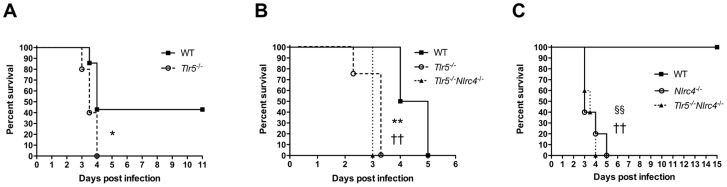

Tlr5 and Nlrc4 independently contribute to survival in respiratory melioidosis.Wild type (WT), Tlr5
−/−, Tlr5
−/−
Nlrc4
−/−, or Nlrc4
−/− mice were infected with A) 361 CFU/lung B) 400 CFU/lung or C) 91 CFU/lung aerosolized B. pseudomallei 1026b and monitored at least daily for survival. N = 5–7 per group (A), 4 per group (B), and 5 per group (C). *, p≤0.05 and **, p≤0.01 for Tlr5
−/− compared to wild type mice;). ††, p≤0.01 for Tlr5
−/−
Nlrc4
−/− compared to wild type mice; §§, p≤0.01 for Nlrc4
−/− compared to wild type mice. No significant differences in survival were noted for Tlr5
−/− or Nlrc4
−/− compared to Tlr5
−/−
Nlrc4
−/− mice.